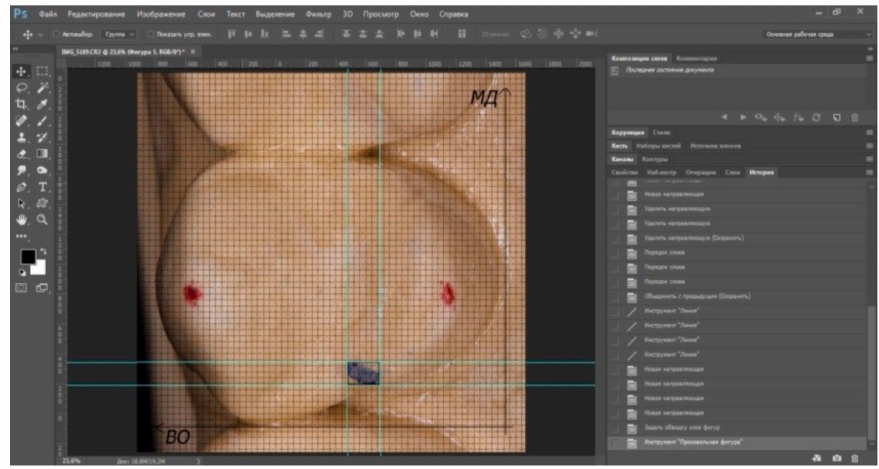
Figure 2. Analysis of deviation of occlusal contact in Adobe Photoshop.